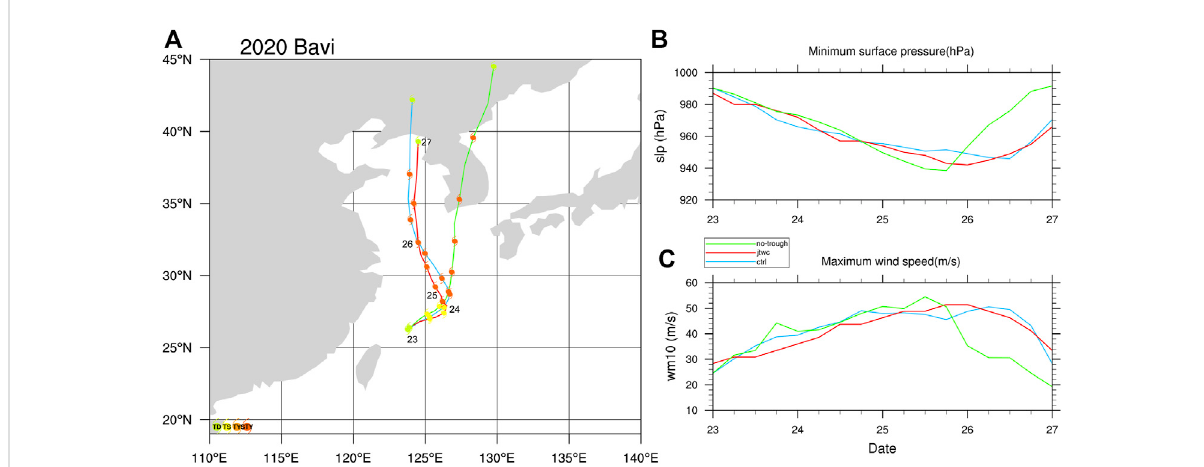
FIGURE 1 (A) TrackofTyphoonBavi(2010)withevery6-hpositionindicatedbysolidcircleswithdifferentcolorsfordifferentcategoriesinstormintensity, (B) the storm ’ s central sea level pressure (hPa), and (C) the maximum sustained 10-m wind speed (m s − 1 ) from 0000 UTC 23 August to 0000 UTC 27 August 2020 based on the JTWC best track data (red) and from both CTRL (blue) and No-trough (green)